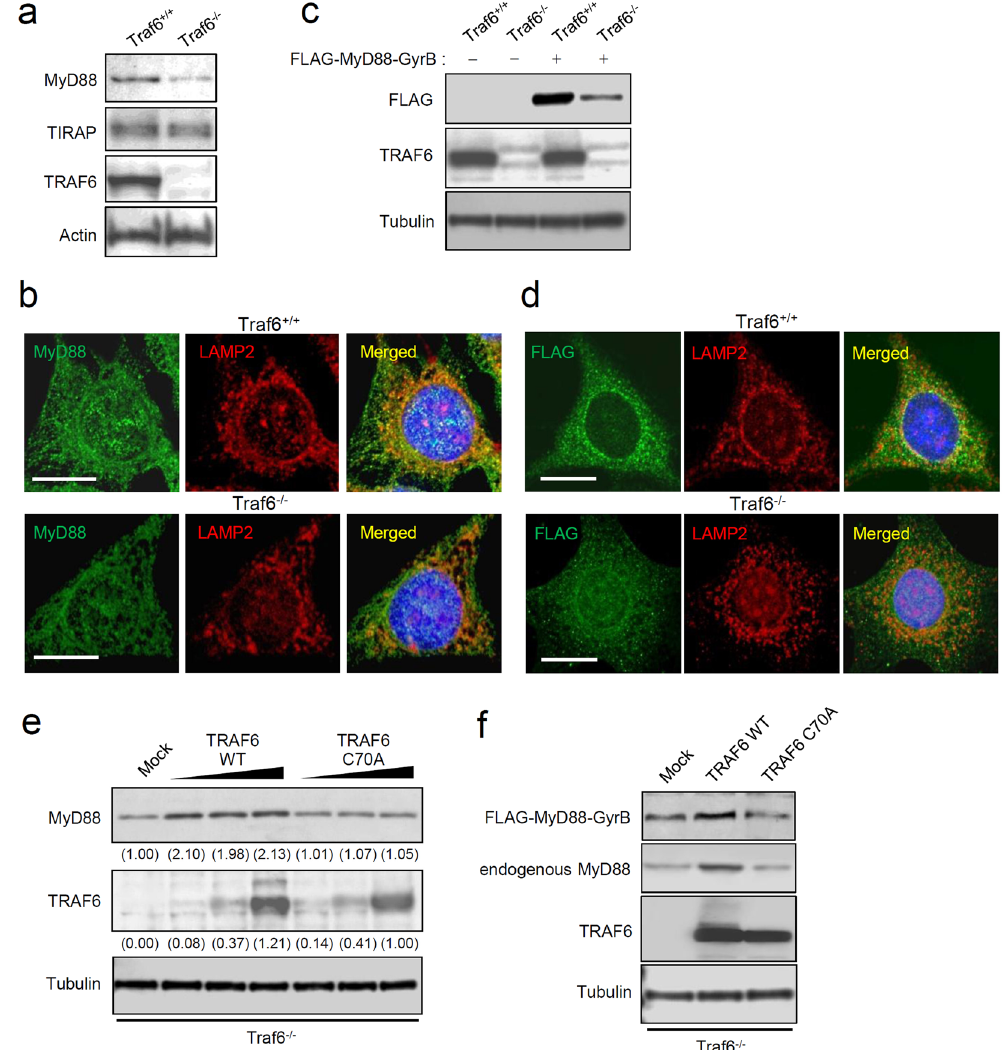
Figure 6. TRAF6 facilitates resistance of MyD88 to degradation. ( a ) Basal MyD88 expression is lowered by TRAF6 deficiency. Expression of MyD88, TIRAP, TRAF6, and actin in Traf6 + / + MEFs and Traf6 − / − MEFs was assessed by immunoblotting. All the blots were obtained under the same experimental conditions, and the cropped images of the blots are shown. The uncropped images are in Supplementary Fig. 23. ( b ) MyD88 speckles are downregulated by TRAF6 deficiency. Immunofluorescent staining of Traf6 + / + MEFs and Traf6 − / − MEFs for MyD88 (green) and LAMP2 (red) was carried out. Cell nuclei were stained with Hoechst 33342. Images were captured by means of a confocal microscope. Scale bar: 10 μ m. ( c ) Stably expressed MyD88-GyrB is downregulated by TRAF6 deficiency. Traf6 + / + MEFs and Traf6 − / − MEFs were stably transfected with a plasmid encoding FLAG-MyD88-GyrB or with an empty plasmid. Expression of MyD88, TRAF6, and α -tubulin was assessed by immunoblotting. All the blots were obtained under the same experimental conditions, and the cropped images of the blots are shown. The uncropped images are in Supplementary Fig. 24. ( d ) Speckles of MyD88-GyrB are downregulated by TRAF6 deficiency. Traf6 + / + MEFs and Traf6 − / − MEFs were stably transfected with the FLAG-MyD88-GyrB construct. Immunofluorescent staining for FLAG (green) and LAMP2 (red) was carried out, and cell nuclei were stained with Hoechst 33342. Images were acquired by means of a confocal microscope. Scale bar: 10 μ m. ( e ) Basal MyD88 in TRAF6-deficient cells is restored by TRAF6. Traf6 − / − MEFs were transiently transfected with increasing amounts of a plasmid encoding FLAG- tagged wild-type TRAF6 (TRAF6 WT) or enzymatically inactive TRAF6 (TRAF6 C70A) or with an empty plasmid (mock). Expression of MyD88, FLAG-TRAF6, and α -tubulin was assessed by immunoblotting. Values within parentheses represent the ratio determined by densitometric measurement of the bands. All the blots were obtained under the same experimental conditions, and the cropped images of the blots are shown. The uncropped images are in Supplementary Fig. 25. ( e ) MyD88-GyrB expressed in TRAF6-deficient cells is restored by TRAF6. Traf6 − / − MEFs stably expressing FLAG-MyD88-GyrB were transiently transfected with a plasmid encoding TRAF6 WT or TRAF6 C70A, or an empty plasmid (mock). Expression of FLAG-MyD88- GyrB, endogenous MyD88, TRAF6, and α -tubulin was assessed by immunoblotting. All the blots were obtained under the same experimental conditions, and the cropped images of the blots are